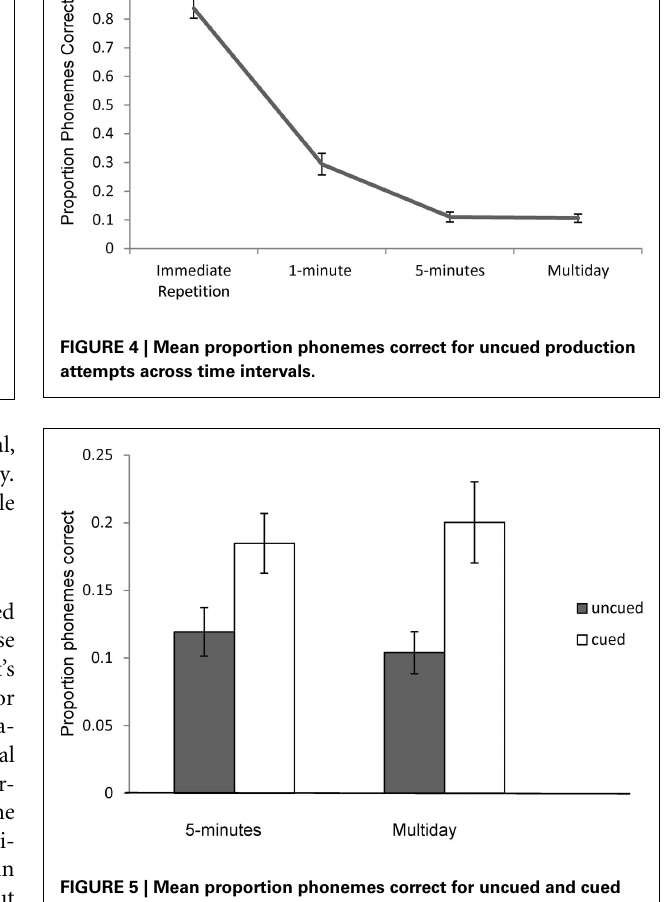
FIGURE 5 | Mean proportion phonemes correct for uncued and cued production attempts across final time